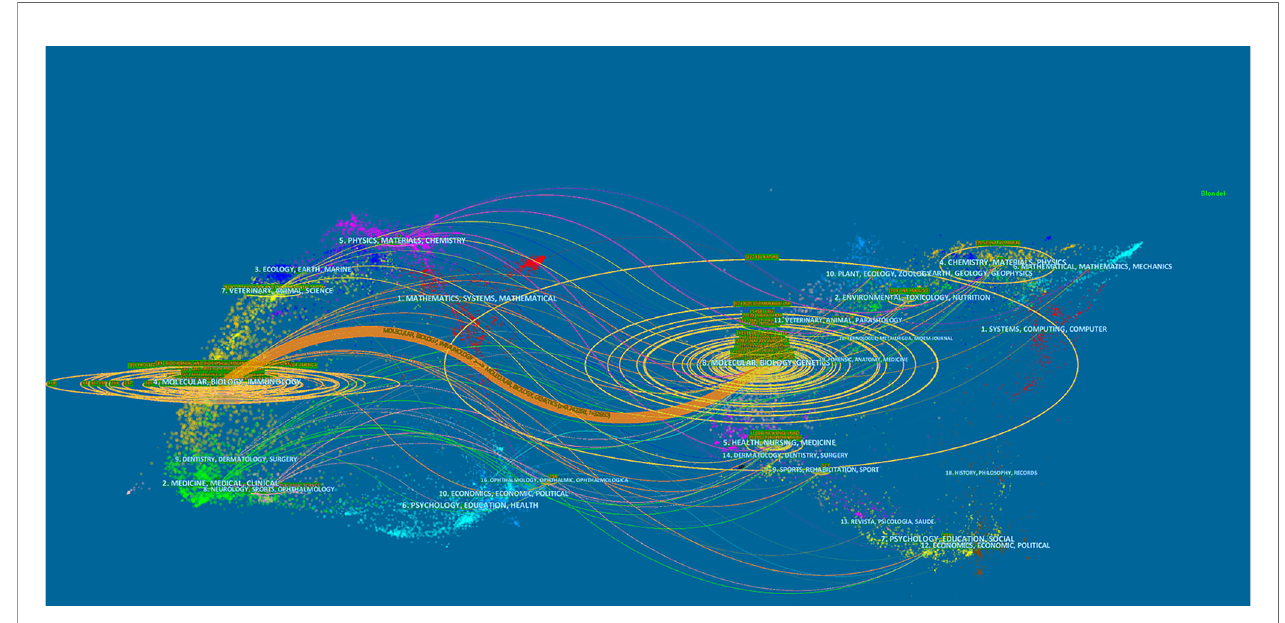
FIGURE 6 | The dual-map overlay of journals on pyroptosis.